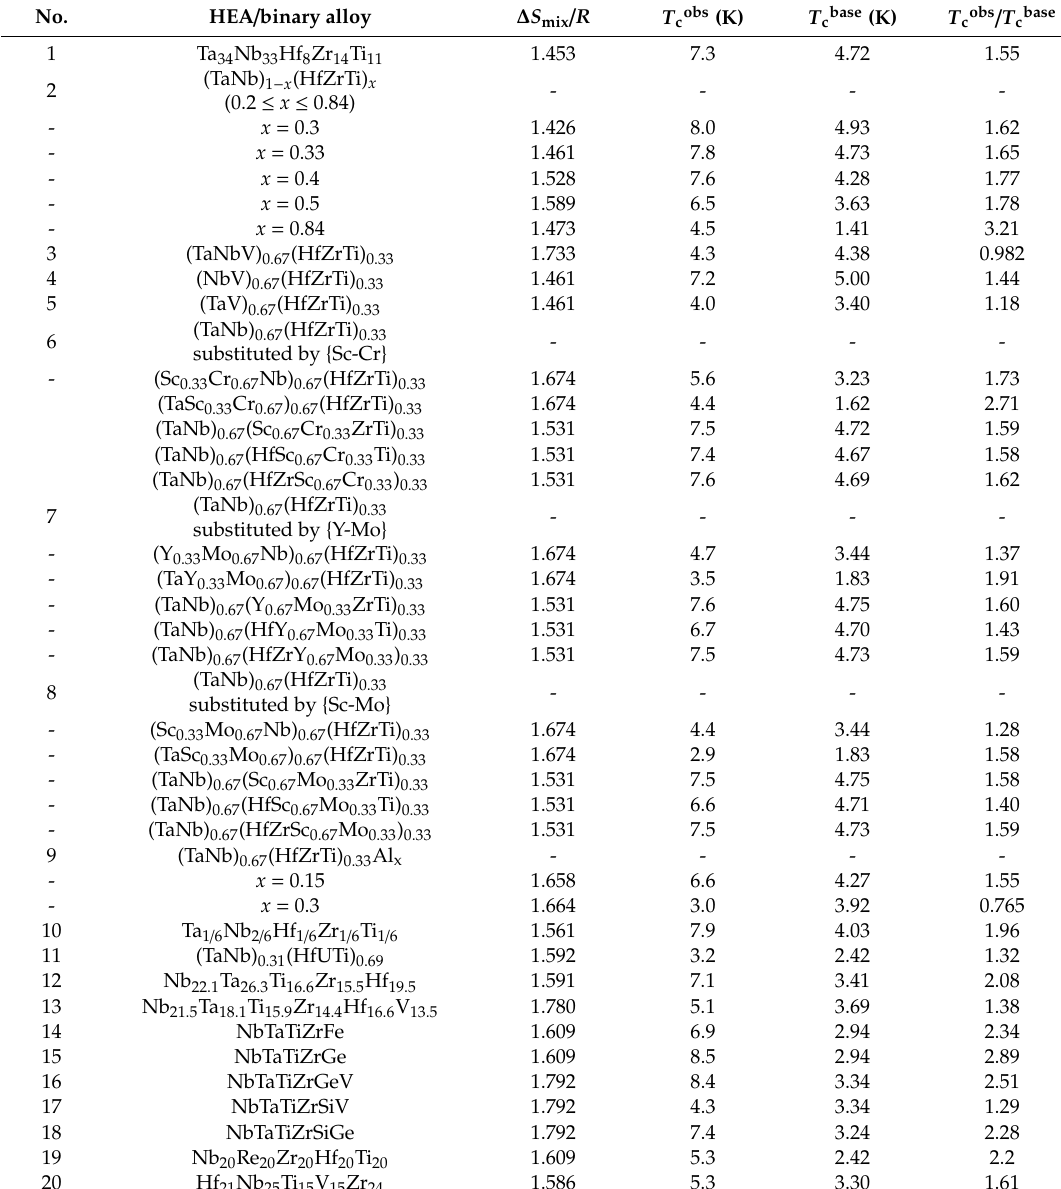
Table 2. ∆ S mix / R , T cobs , T cbase , and T cobs / T cbase of bcc HEA and binary alloy (Nb 66 Ti 33 , Ta 50 V 50 , Ti 20 V 80 )